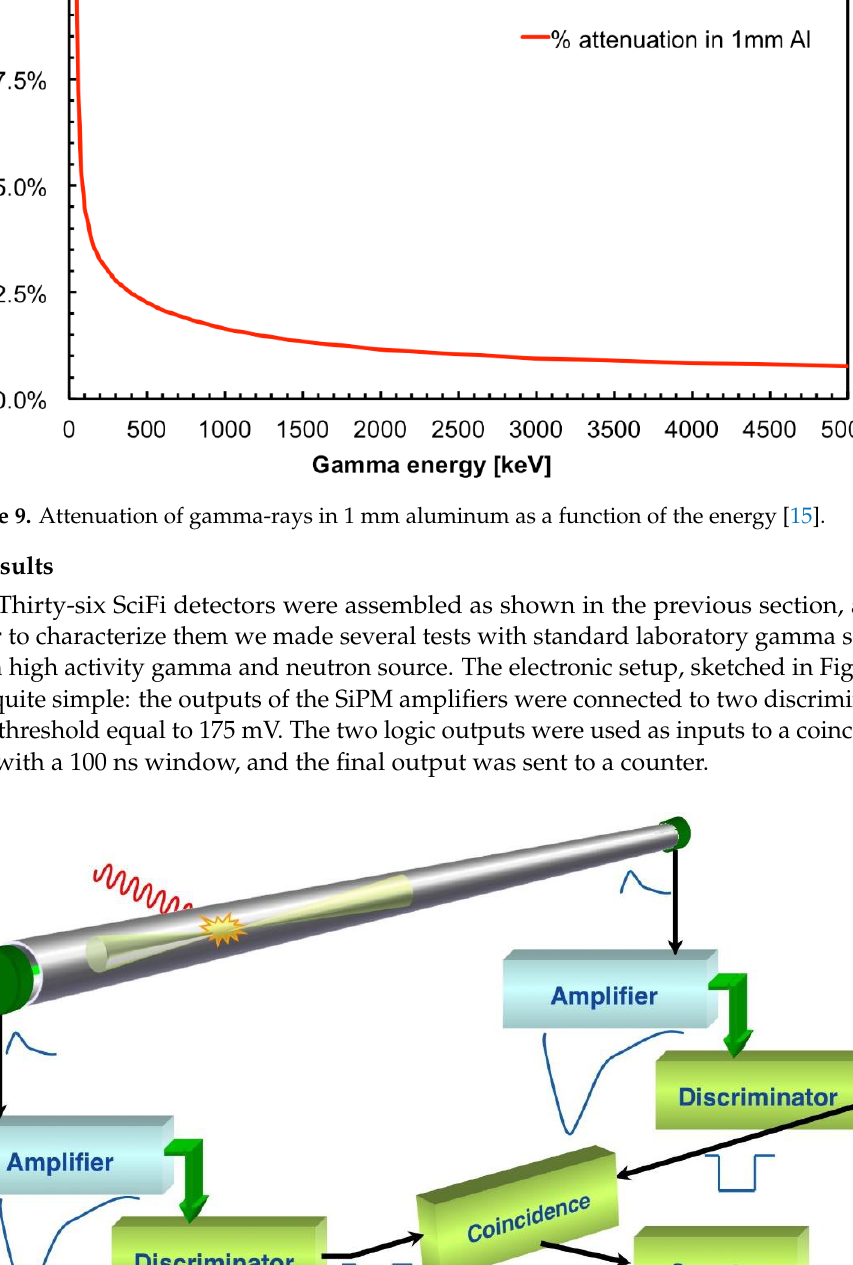
Figure 8. ( a ) Sketch of the components of the SciFi detector assembly . ( b ) A fiber holder with the SiPM PCB in place. ( c ) A detector fully assembled. ( d ) A 3 mm diameter fiber.